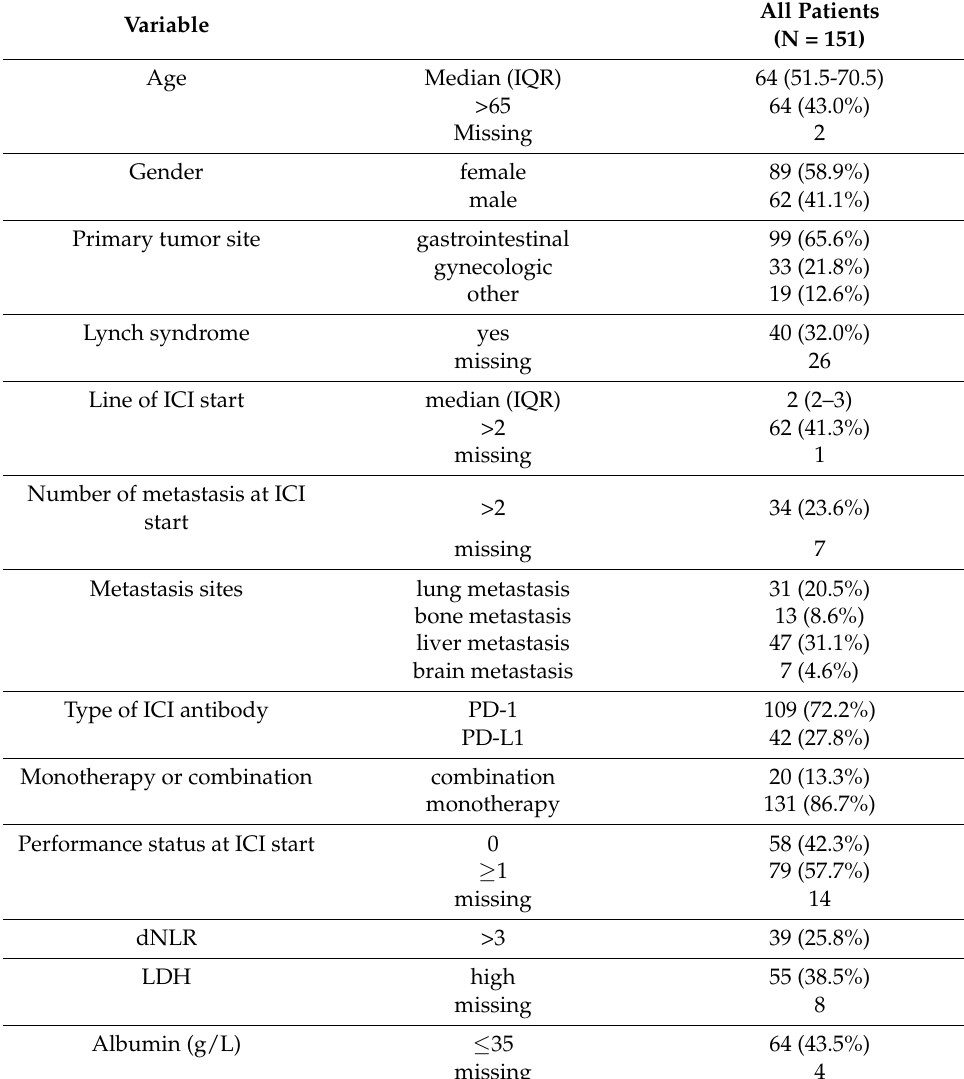
Table 1. Clinical, pathological and biological characteristics of the